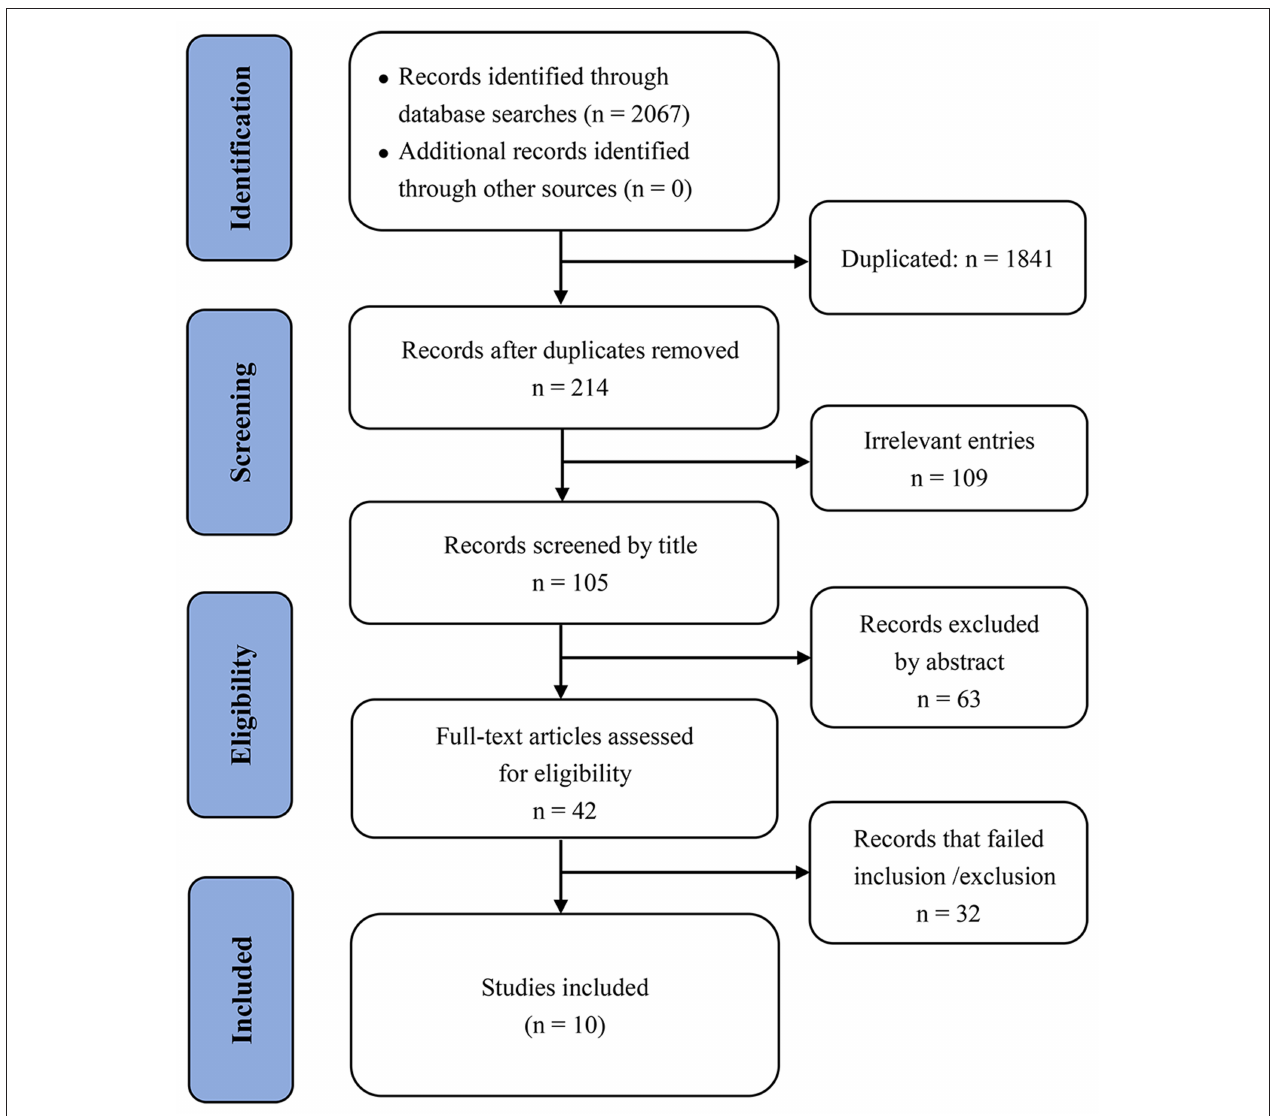
FIGURE 1 | Prisma flow diagram of article